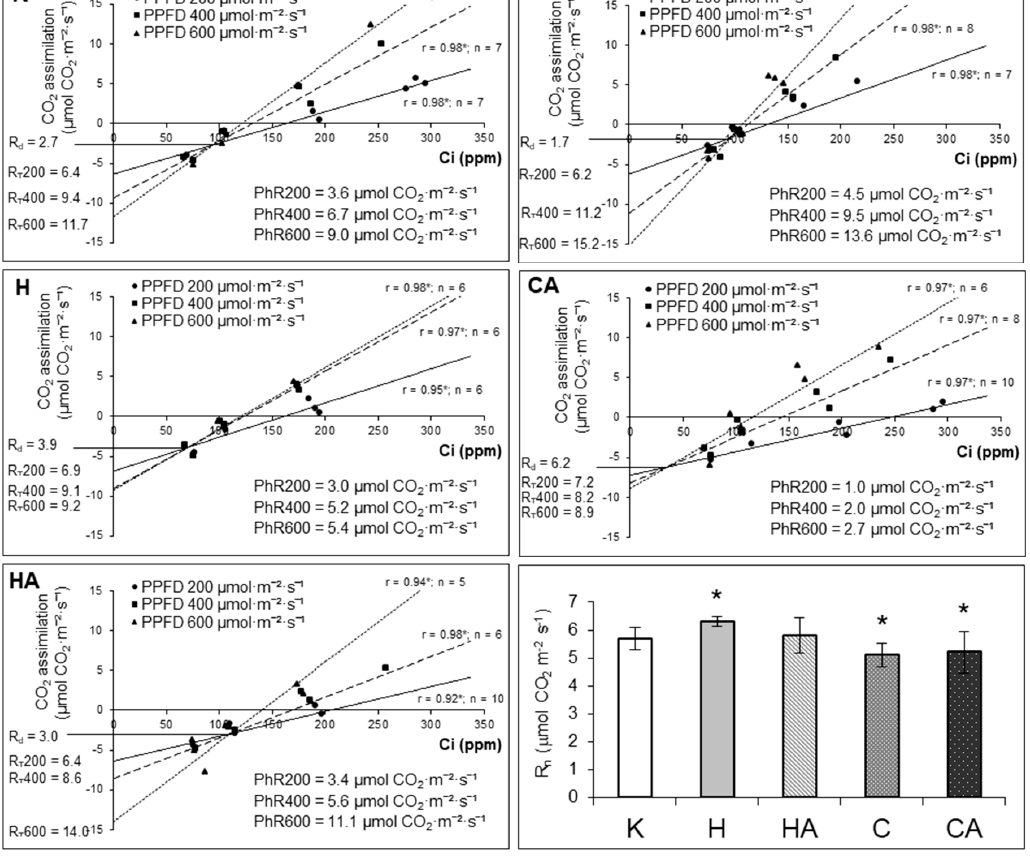
Figure 5. Changes in cauliflower leaf light (R d ), dark (R n ) respiration as well as total light (R T ) respiration and (PhR) photorespiration (all expressed in µ mol CO 2 m − 2 ·s − 1 ) at 200 (R T 200 and PhR200), 400 (R T 400 and PhR400) and 600 (R T 600 and PhR600) µ mol m − 2 ·s − 1 illumination rate in control grown ( K ), heat-stressed ( H ), heat-recovered ( HA ), cold-stressed ( C ) and cold-recovered ( CA ) plants. All parameters were measured on 3-month-old plants with fully developed leaves with the application of an infrared gas analyser. Data were recorded after at least 2 h of illumination. During the experiment, each of the analysed leaves were placed into a 6-cm 2 chamber of the analyser. Results were recorded after initial leaf acclimation to the desired light and CO 2 concentration, relative humidity and temperature. The R d rate was determined according to the Laisk [55] method. The photorespiration rate for each PPFD value was determined as the difference between R T and R d values. Error bars denote ± S.D. Asterisks indicate significantly different curves at p = 0.05 (Student’s t -test). Further experimental details in Materials and Methods.